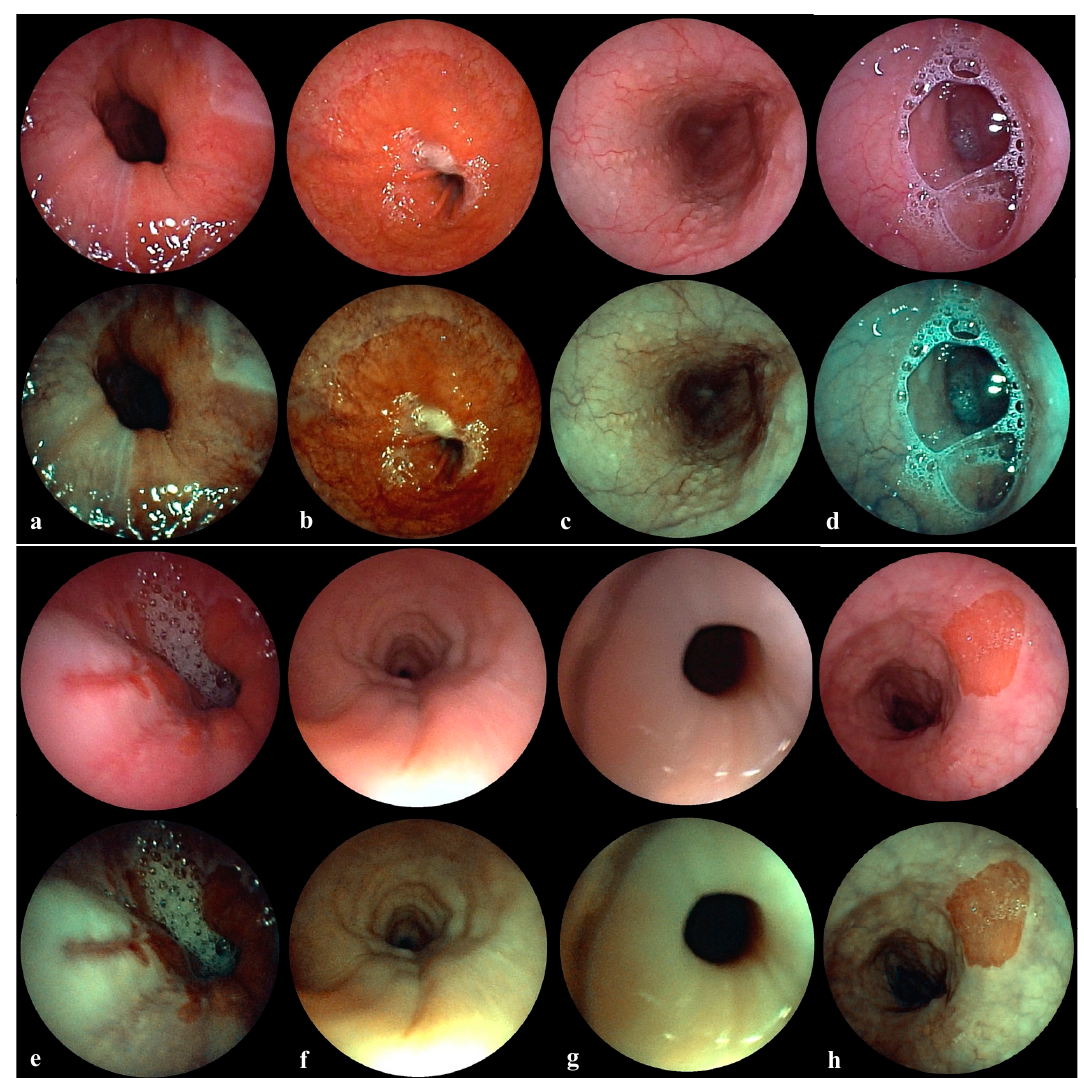
Figure 1. ( a ) Insufficient cardia. White light endoscopy (upper image) demonstrates an insufficient lower esophageal sphincter with a gaping cardia. Chromoendoscopy (lower image) shows gastric mucosa in brown and esophageal mucosa in green thus highlighting the transition zone (Z-line). ( b ) Hiatal hernia. White light endoscopy (upper image) demonstrates a large sliding hiatal hernia after applying abdominal pressure. Chromoendoscopy (lower image) shows gastric mucosa in brown and esophageal mucosa in green thus highlighting the transition zone (Z-line). ( c ) Lymphoid follicles. White light endoscopy (upper image) demonstrates multiple lymphoid follicles along the entire esophagus. Chromoendoscopy (lower image) shows lymphoid tissue in white and dilated vessels in dark green thus highlighting mild mucosal inflammation. ( d ) Visible reflux. White light endoscopy (upper image) demonstrates foamy reflux of stomach contents into the upper esophagus. Chromoendoscopy (lower image) shows lymphoid tissue in white and dilated vessels in dark green thus highlighting mild mucosal inflammation. ( e ) Peptic esophagitis. White light endoscopy (upper image) demonstrates several erosive lesions of the lower esophagus affecting more than one longitudinal fold without confluence (Los Angeles Grade B). Chromoendoscopy (lower image) shows mucosal erosions in dark brown and normal esophageal mucosa in green thus highlighting the inflamed area. ( f ) Tertiary contractions. White light endoscopy (upper image) demonstrates reflux induced uncoordinated contractions of the esophagus. Chromoendoscopy (lower image) clearly shows the circular contraction rings moving esophageal contents in an uncoordinated manner. ( g ) Insufficient upper esophagus sphincter. White light endoscopy (upper image) demonstrates an insufficient upper esophageal sphincter with permanent